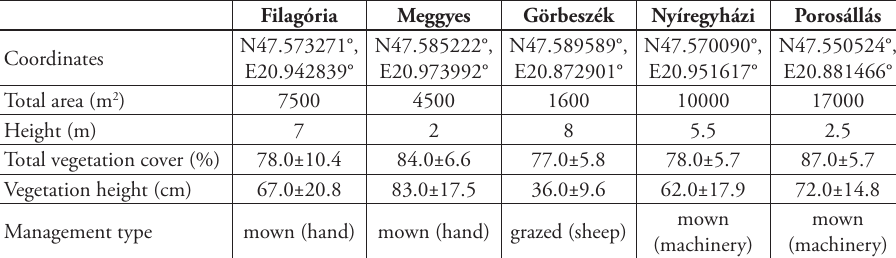
Table 1. Site characteristics of the studied